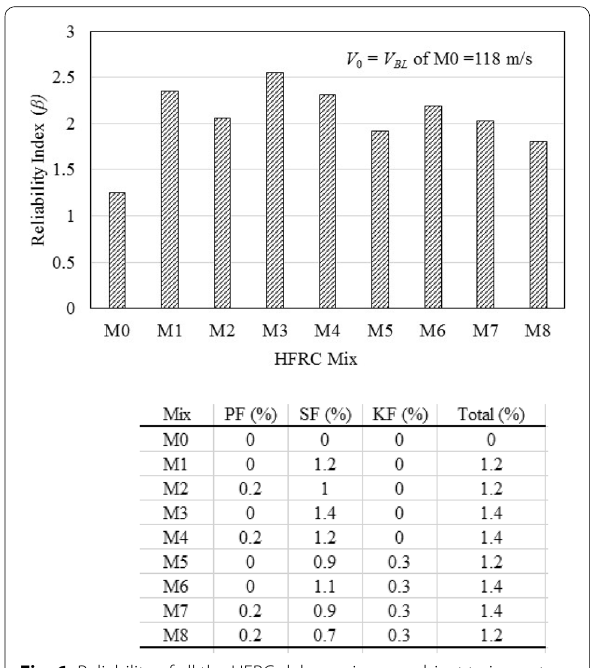
Fig. 6 Reliability of all the HFRC slab specimens subject to impact velocity of 118 m/s.